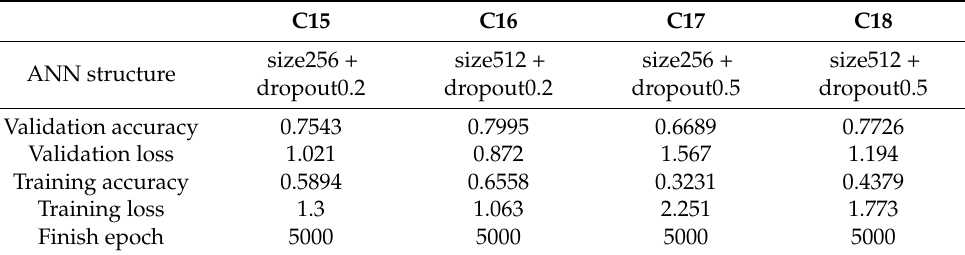
Table 7. Layer size and dropout percentage